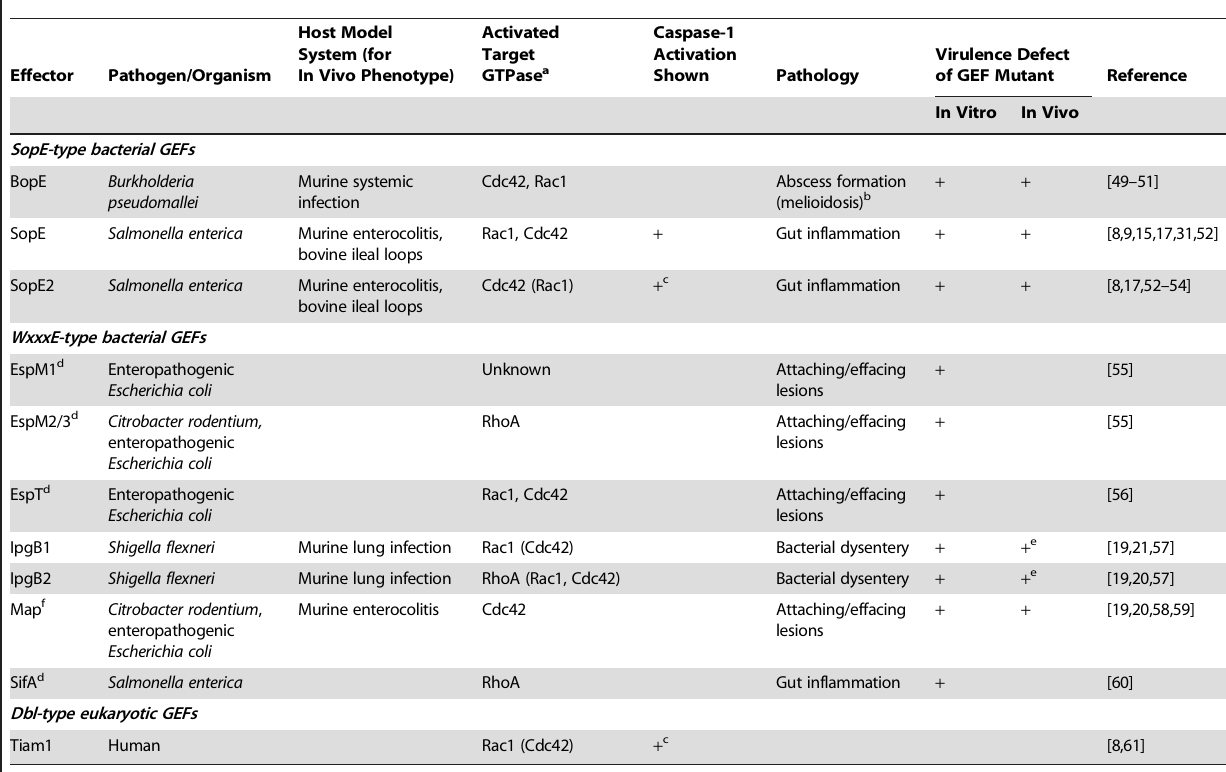
Table 1. Guanine Nucleotide Exchange Factors Involved in Pathogenesis and/or Caspase-1 Activation.